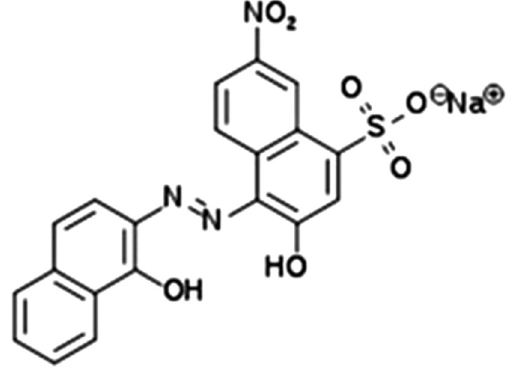
Fig. 2 Electrocoagulation reactor. (1) Glass bath cell; (2) cathodic electrodes; (3) anodic electrodes; (4) magnetic stir bar; (5) stirrer; and (6) DC power